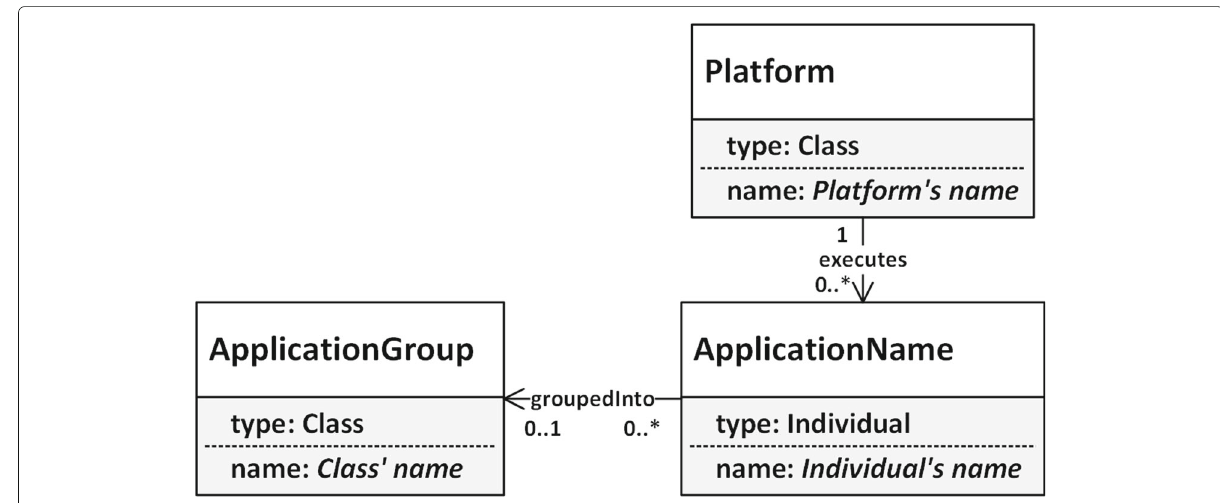
Fig. 7 Grouping of software names